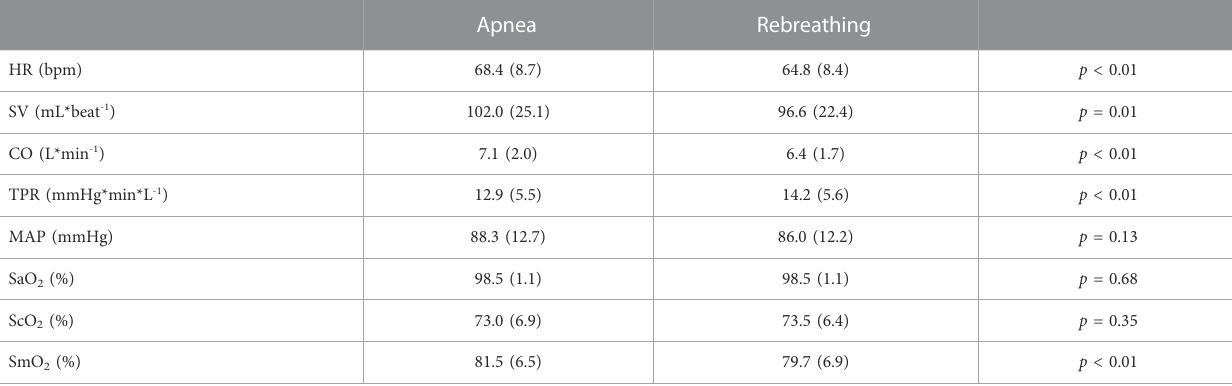
TABLE 1 Control values for cardiovascular variables and oxygen saturations, recorded 60 – 30 s before the onset of each apnea or rebreathing period.